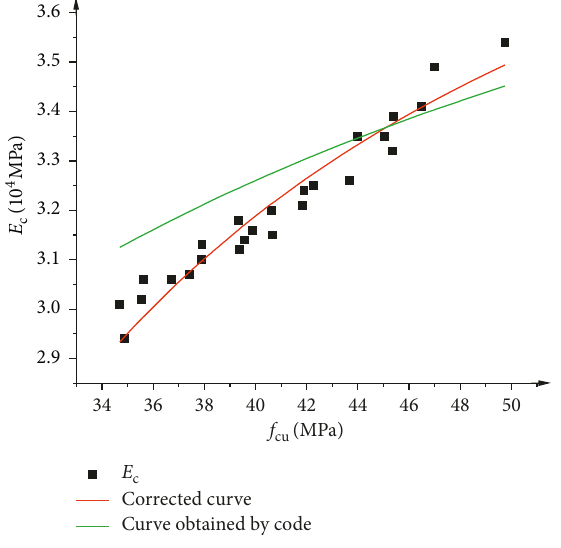
Figure 13: Curves of